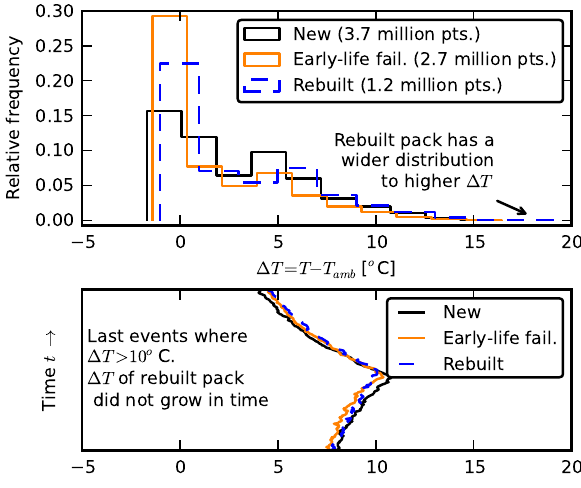
Figure 17. Comparison of heating of aging batteries.